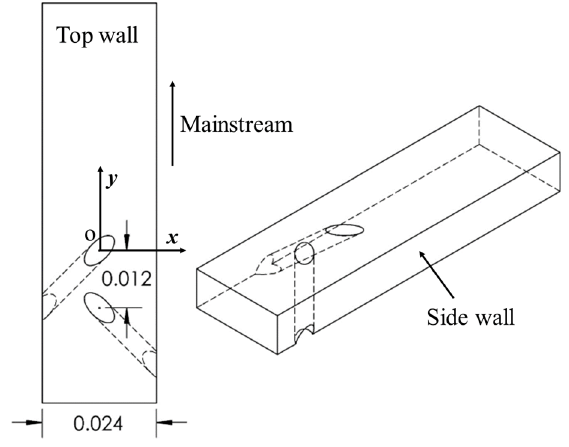
Figure 1. Flat plate geometry and coordinate.